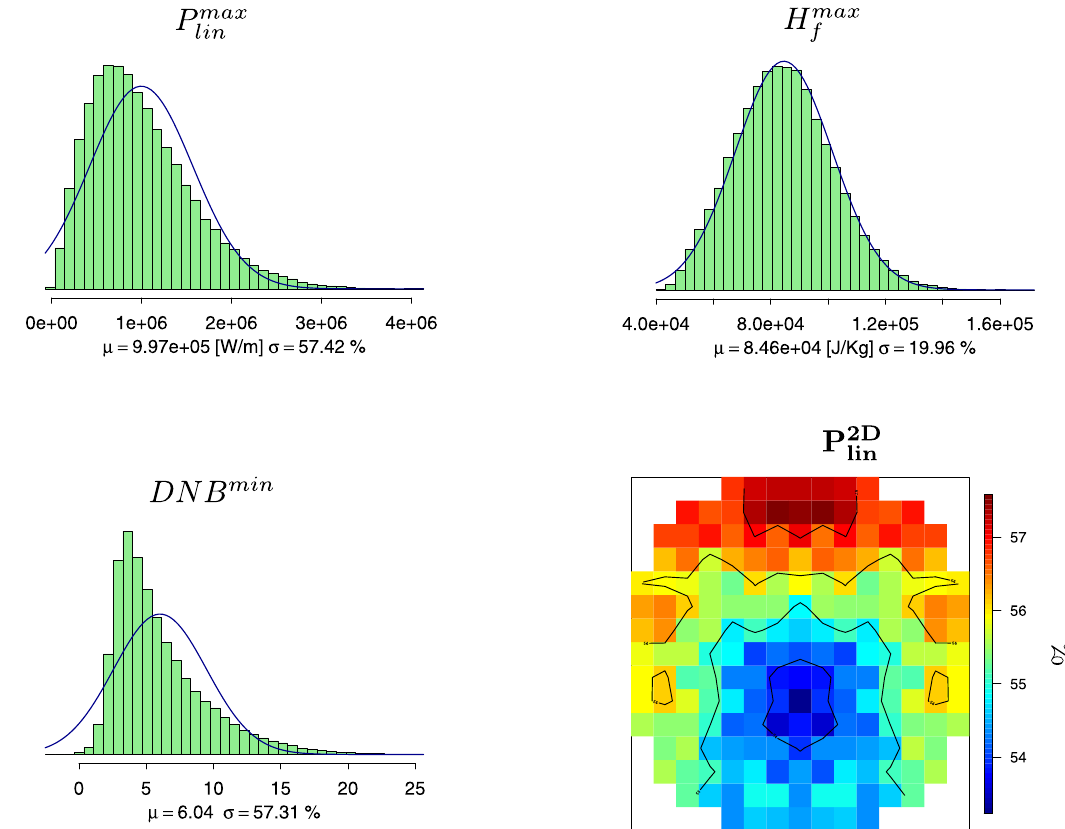
relative standard deviation distribution for BE UQ lin